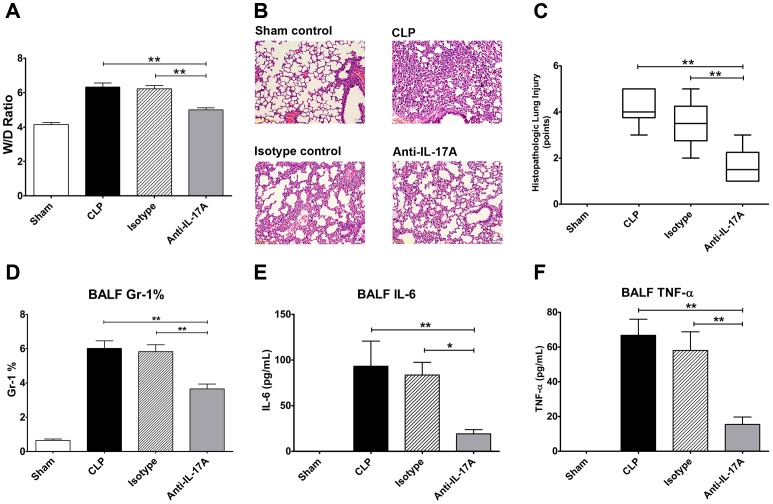
Intraperitoneal anti-IL-17A antibody administration decreased sepsis induced lung injury.The mice underwent a sham procedure, CLP, CLP with intraperitoneal anti-IL-17A, or isotype administration (n = 10 for each group). Bronchoalveolar lavage fluid (BALF), lung, blood, and peritoneal lavage fluid were harvested 24 h after surgery. (A) The wet-to-dry ratio was used to show lung injury in the four groups. (B) Representative HE-stained lung sections. (C) Histopathological score based on HE-stained lung sections, which showed the severity of lung injury. (D) Percentage of neutrophil granulocytes in bronchoalveolar lavage fluid (BALF) after adminitration of anti-IL-17A in the four groups. After treated with anti-IL-17A antibody after CLP and sham surgery, BALF IL-6 level (E) and TNF-α level (F) were detected to evaluate the lung injury. **P<0.01, *P<0.05.